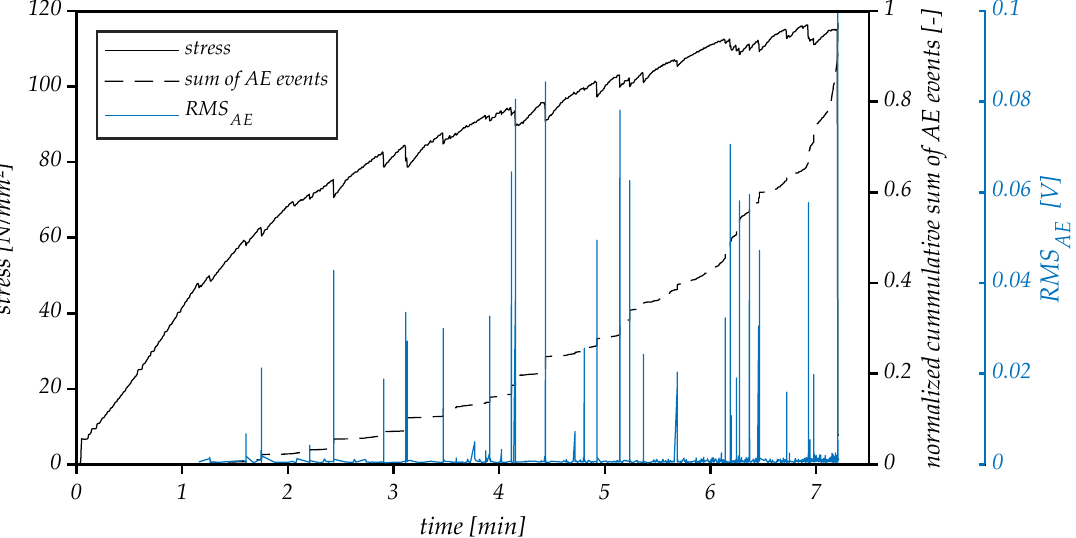
Figure 9. AE signal’s characteristics, RMS_AE and the normalized cumulative sum of AE events and stress curve for the miniature beam specimen.